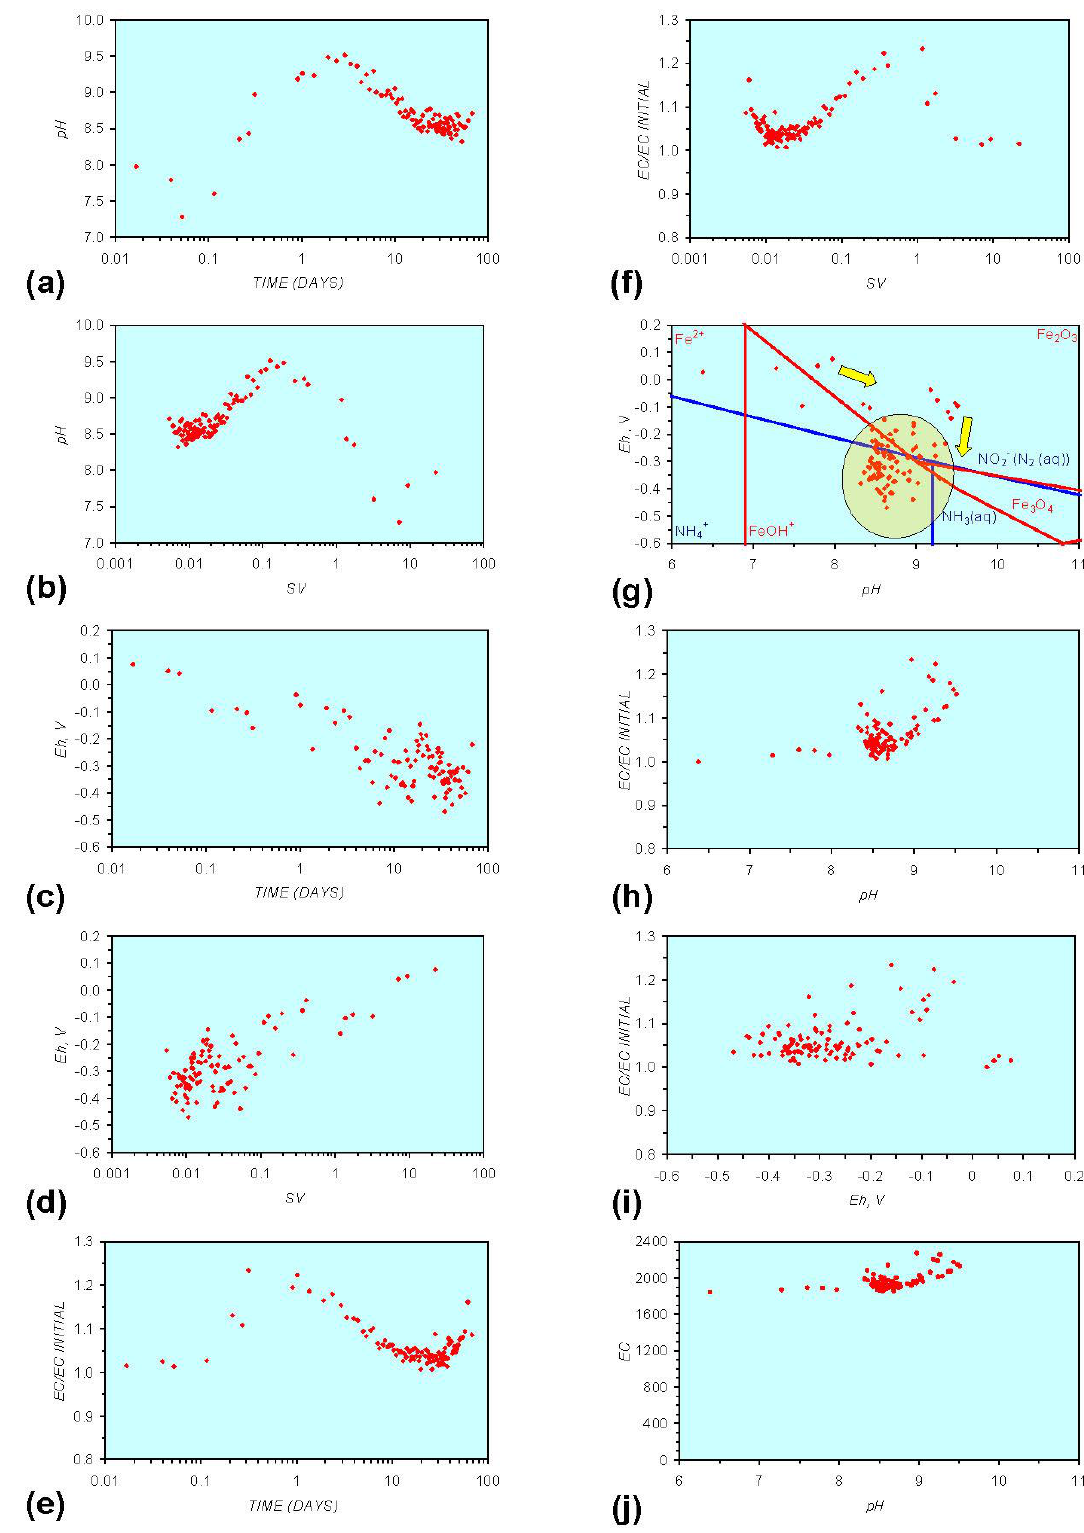
Figure A15. MR15: Ca-montmorillonite + n-Fe 0 + n-Al 0 , saline water. (a) pH vs. Time; (b) pH vs. SV; (c) Eh vs. time; (d) Eh vs. SV; (e) EC/EC Initial vs. time; (f) EC/EC Initial vs. SV; (g) Eh vs. pH (SRE ringed); (h) pH vs. EC/EC Initial; (i) Eh vs. EC/EC Initial; (j) pH vs. E(C) Arrows indicate decreasing SV and increasing